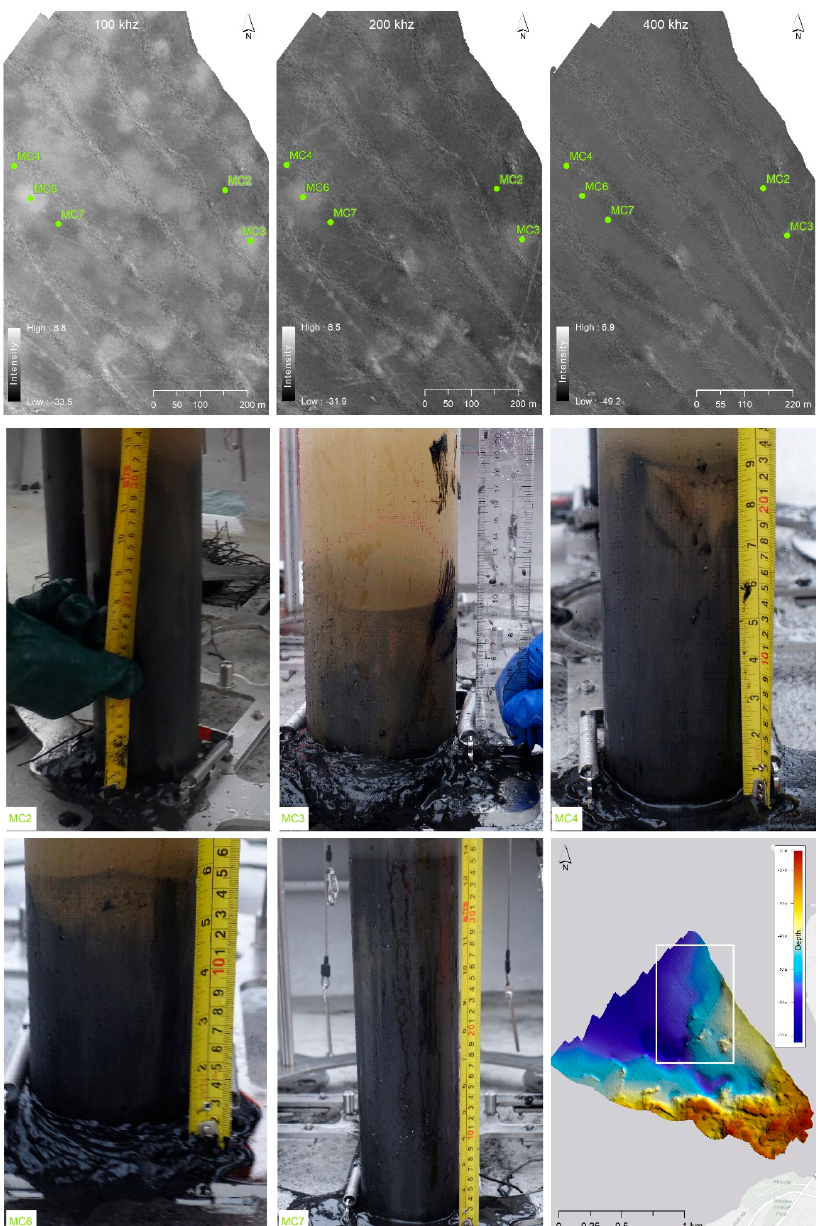
Figure 8. Example of benthic core samples from three adjacent sampling stations overlaid on the 2017 multispectral backscatter mosaics (100, 200, and 400k Hz). Differences in the backscatter intensities correspond to changes in core penetration depths, suggesting that the high intensity backscatter features visible in the lower frequency mosaics correspond to harder material (dredge spoil) beneath a surface covering of mud.